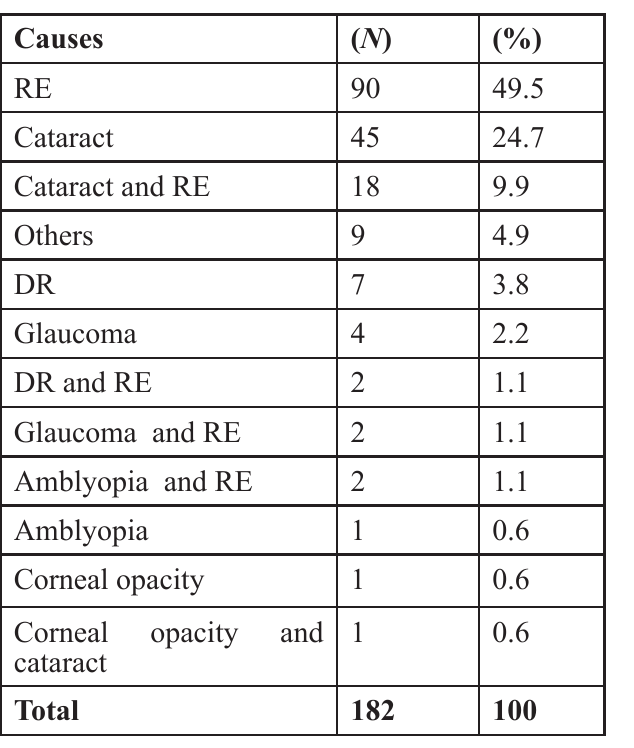
Table 3: The causes of visual impairment (VI) and blindness based on uncompensated visual acuity values, number (N) and percentages (%) of participants. ‘Others’ refers to causes such as stroke (as reported by participant), strabismus, retinal scars, etc.